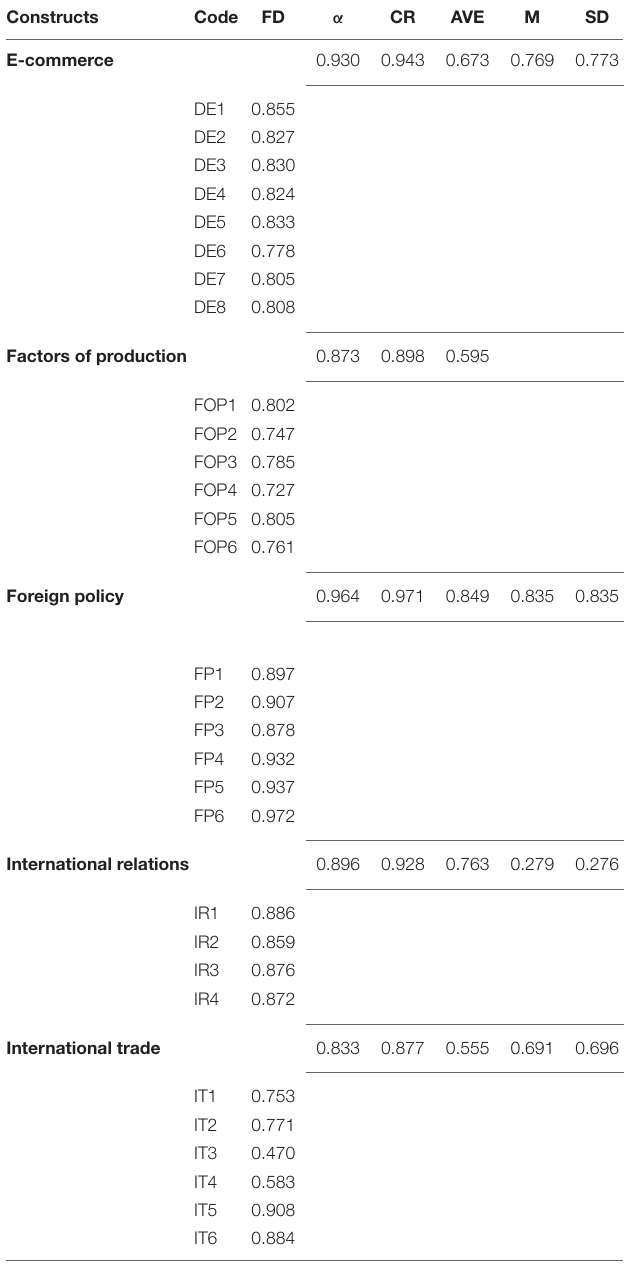
TABLE 2 | Measurement model and descriptive